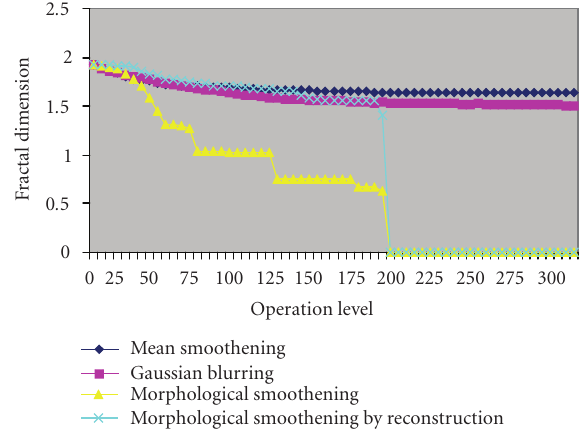
Figure 5.2. The e ff ects of DEM smoothening on the DEM of Lake